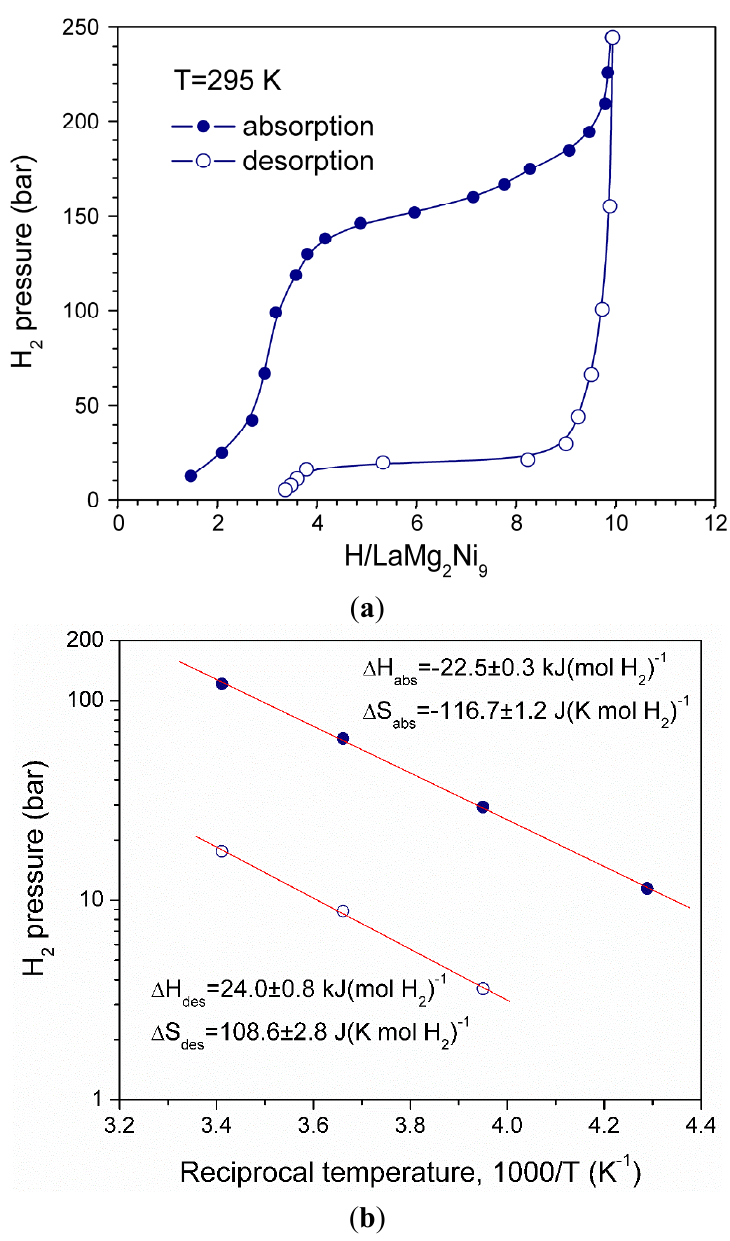
Figure 2. Room temperature isotherms of hydrogen absorption and desorption ( a ); and van’t Hoff plots ( b ) for La 1.09 Mg 1.91 Ni 9 -based hydride. At room temperature equilibrium pressure of hydrogen absorption is ~120 bar D 2 , while for the desorption P eq . equals to ~20 bar D 2